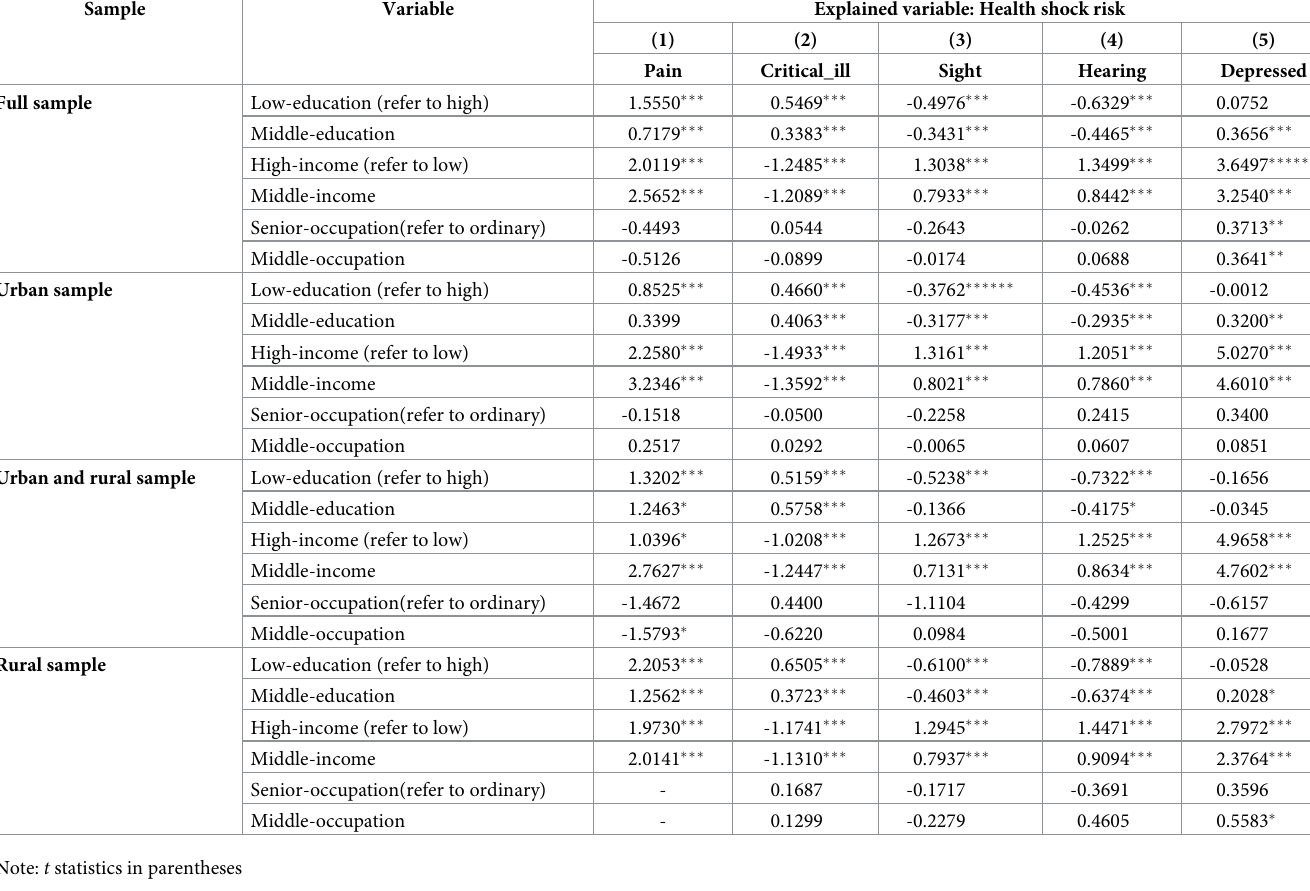
Table 4. Health shock test results of SES on the older adults under sub samples.